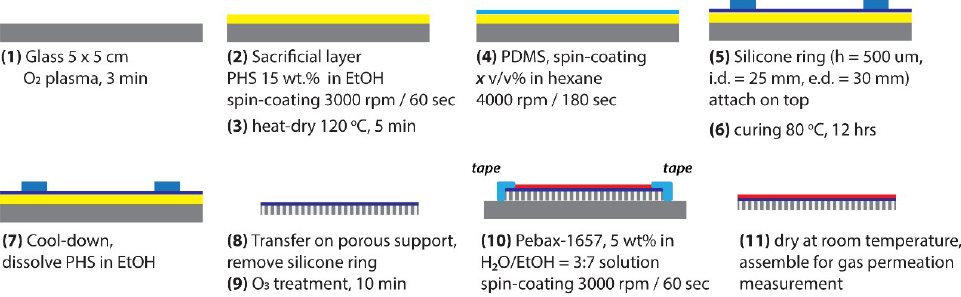
Figure 2. Schematic procedure of the Pebax-1657/PDMS/porous support thin film composite (TFC) membrane fabrication.